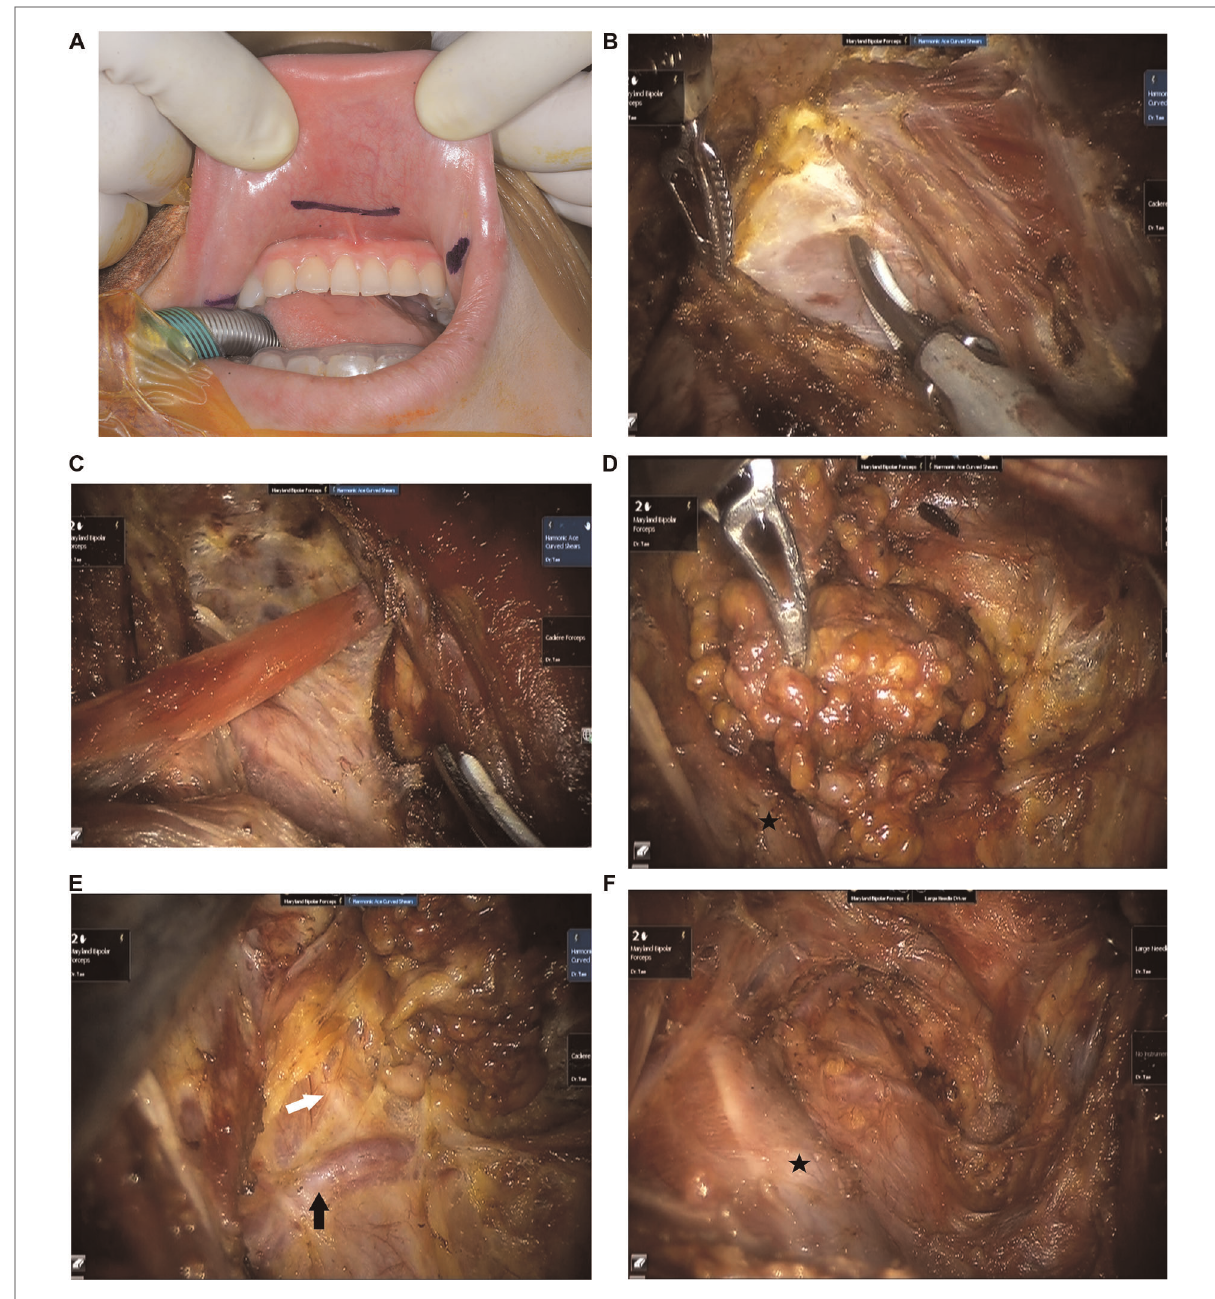
FIGURE 1 Operative procedure of transoral robotic selective neck dissection. ( A ) Three vestibular incisions are made. ( B ) The fascia overlying the sternocleidomastoid muscle is dissected to expose the internal jugular vein. ( C ) The omohyoid muscle is exposed and cut. ( D ) Lymph nodes and fi brofatty tissue of levels III and IV are dissected. ( E ) The transverse cervical artery and the phrenic nerve are preserved. Black arrow: transverse cervical artery, white arrow: phrenic nerve. ( F ) Surgical view after completion of selective neck dissection of levels III and IV. Black star: internal jugular